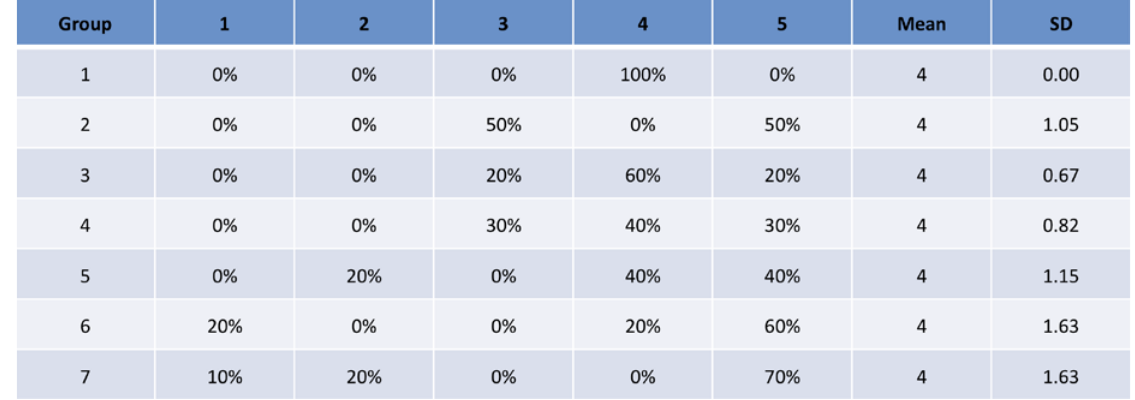
Different Group Distributions that Produce a Mean Score of